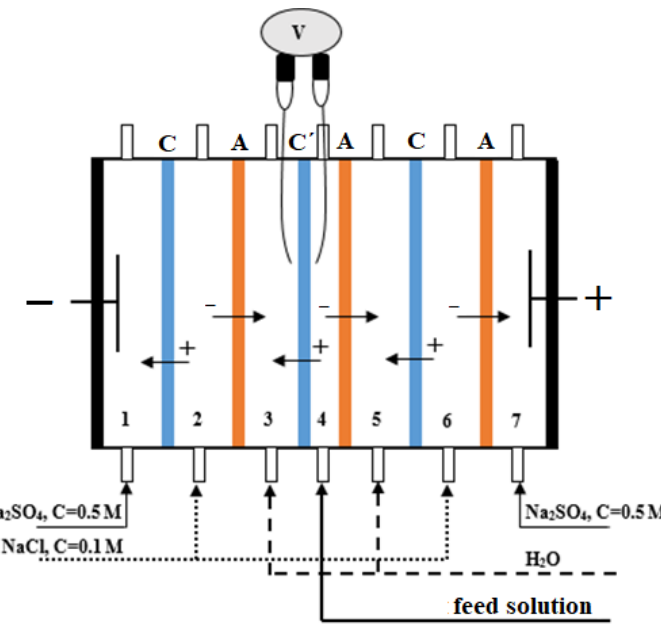
Figure 3. Schematic representation of the electrodialyzer with alternating cation-exchange membranes MK-40 (C) and anion-exchange membranes MA-41 (A). C (cid:48) —cation-exchange membrane under study. 1 – 7 —section numbers. V—digital multimeter.